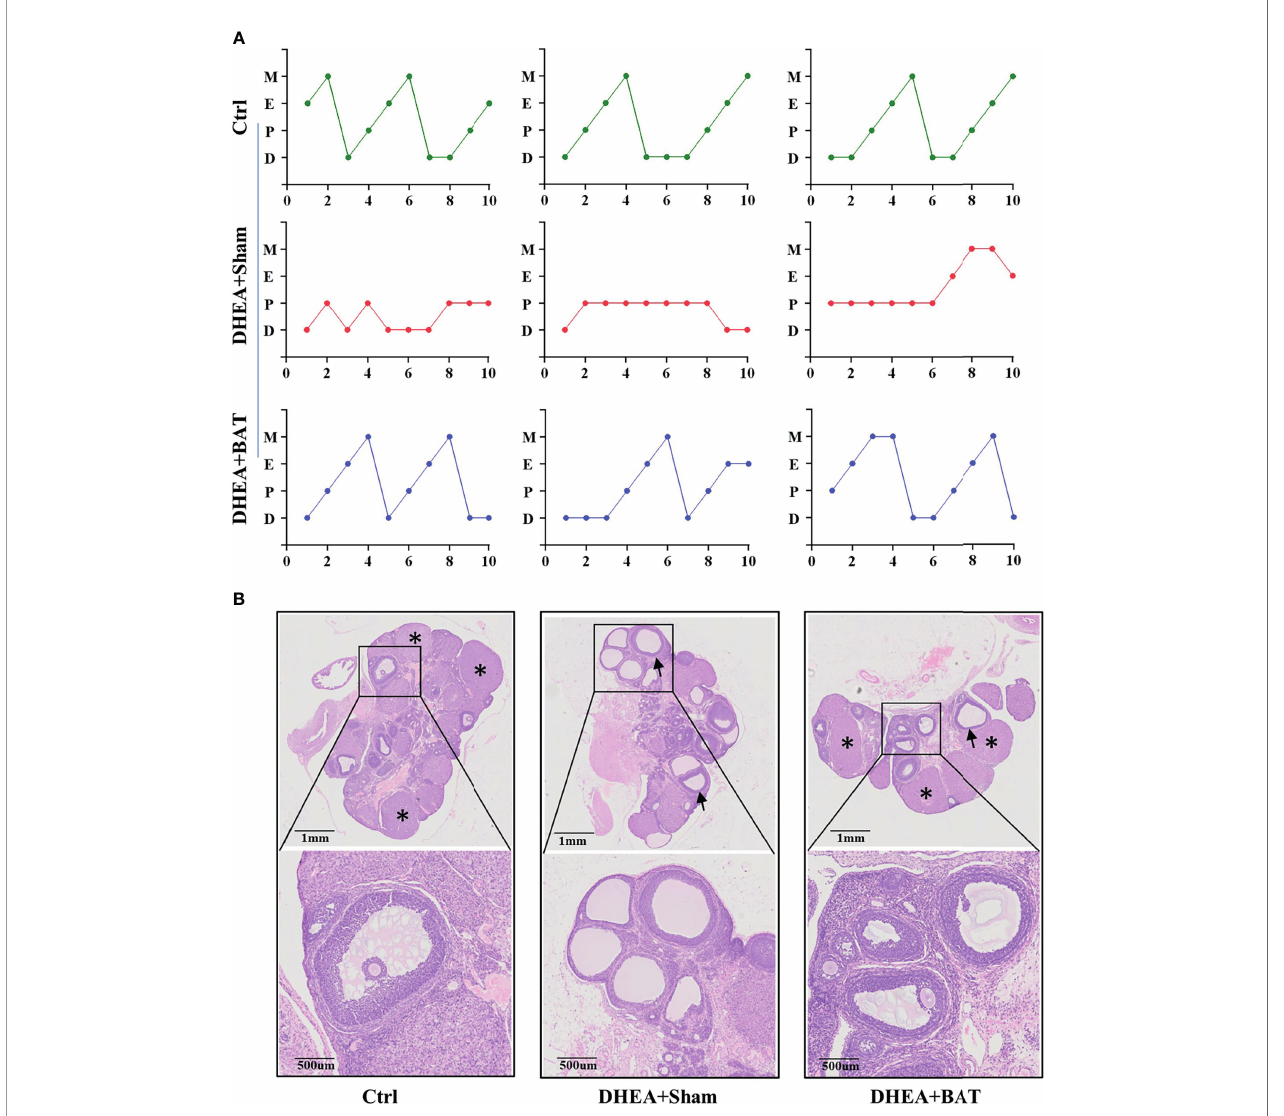
FIGURE 2 | Brown adipose tissue (BAT) transplantation improved the reproductive phenotype of polycystic ovary syndrome (PCOS) model rats. (A) Disordered estrous cycles were observed in the DHEA+Sham group, while BAT transplantation rescued the abnormal estrous cycles. (B) Representative results of ovarian H&E staining of the control (Ctrl) group, DHEA+Sham group, and DHEA+BAT group. Ovarian histology revealed that cystic follicles ( arrow ) and a few corpora lutea ( asterisk ) appeared in the DHEA+Sham group compared with the Ctrl group, while BAT transplantation reversed the phenotype caused by dehydroepiandrosterone (DHEA). H&E , hematoxylin – eosin; D , diestrus; E , estrus; M , metestrus; P , proestrus; UCP1 , uncoupling protein